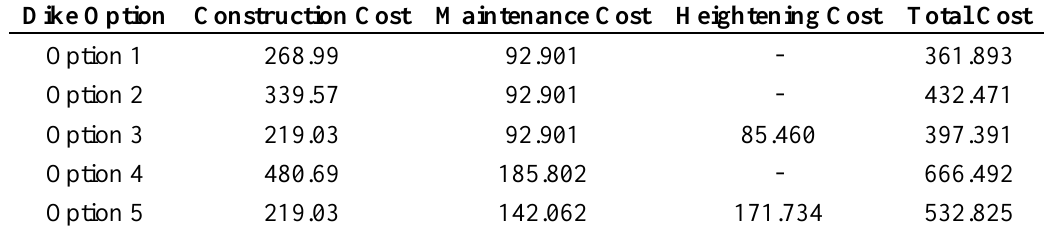
Table 3. Costs of dike options (discount rate = 3%, unit: million